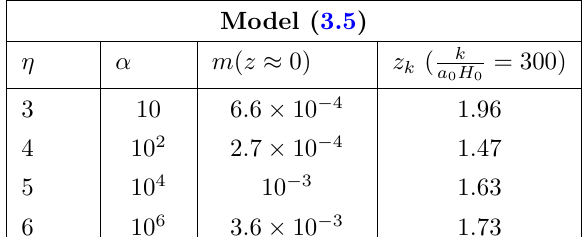
Table 1 . Some numerical values for the transition redshift and m = Rf ,RR